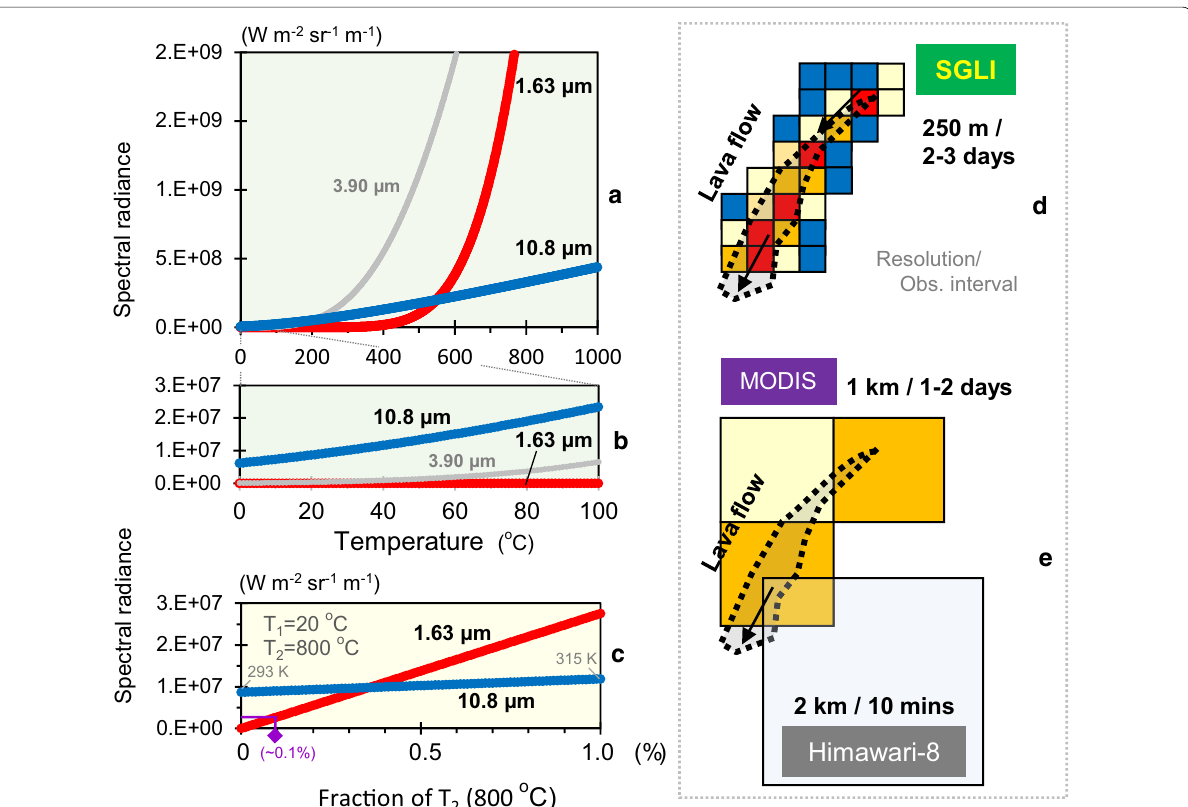
Fig. 1 a , b Relationship between temperature and spectral radiance based on the Planck equation. c Relationship between fraction of high-temperature portion within a pixel (%) and spectral radiance at 1.63 µm and 10.8 µm. The high-temperature portion (T 2 ) and the background (T 1 ) are assumed to be 800 °C and 20 °C, respectively. d Schematic illustration of the relationship between pixel size of the SGLI and a small to medium lava flow. e Schematic illustration showing the relationship between pixel size of the MODIS and Himawari-8 and a small to medium lava